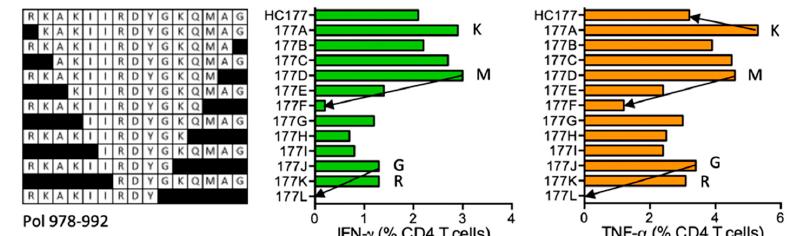
RKAKIIRDYGKQM (RM13), and RKAKIIRDYG (RG10), and from KAKIIRDYGKQMAG (KG14) down to RDYGKQMAG (RG9) (Figure 18). No epitopes were listed in the LANL-HSD for this Pol